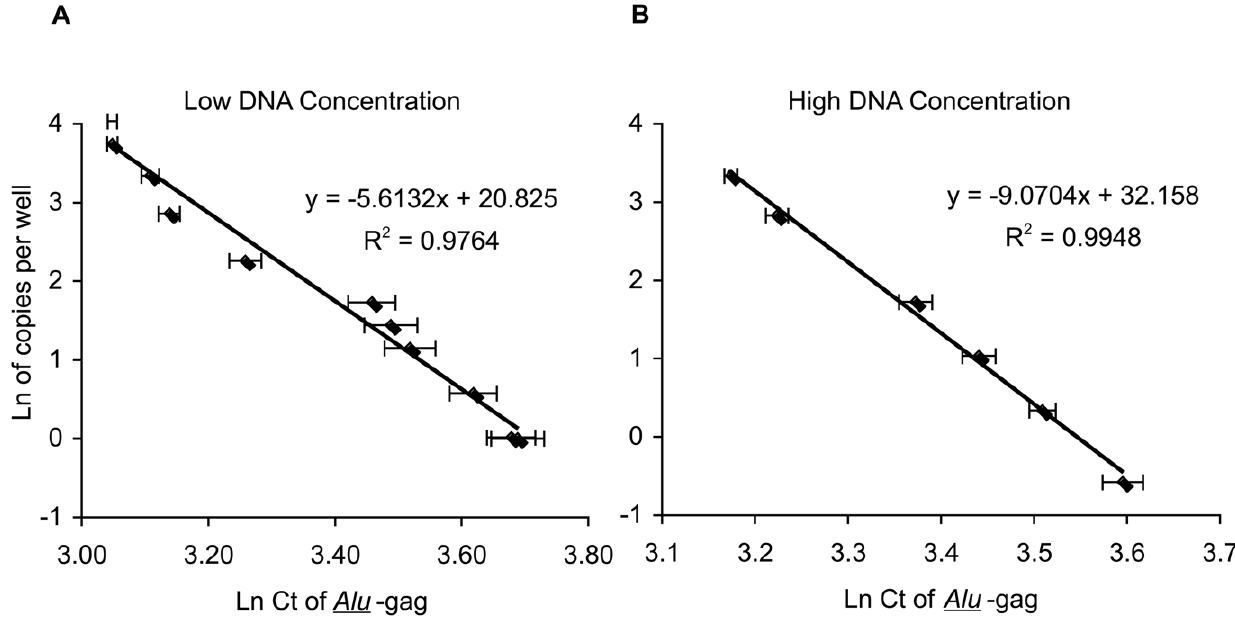
Figure 1. Linear correlation between Ln (Ct of Alu - gag ) and Ln (HIV DNA copies per well) at low and high DNA concentrations. The integration standard was diluted in PBMC DNA from HIV-negative donors at 2 ( A ) or 40 ( B ) m g/ml as indicated for each standard curve in order to obtain samples containing known numbers of integrated HIV DNA copies. 25 m l of the standard were then assayed per well after adding 25 m l of the PCR master mixture for a total of 50 m l in each reaction. The final concentration of HIV DNA in each well is therefore, 1 and 20 m g/ml for the low and high DNA concentrations, respectively. Each point represents the average Ln(Ct) for 42 replicates.